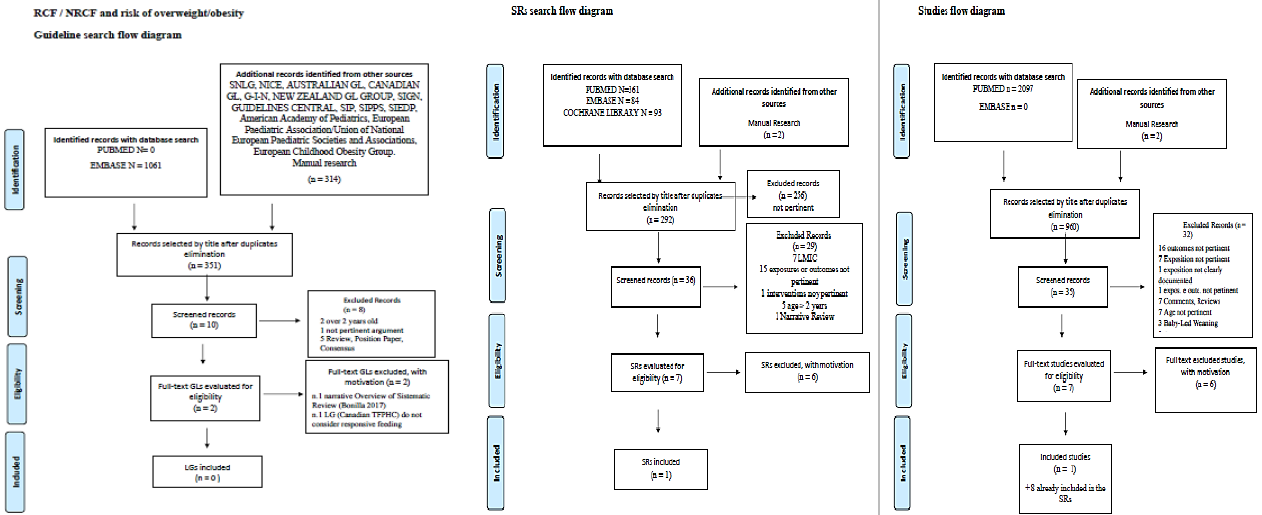
Figure 2. RCF/NRCF and risk of overweight/obesity. Flow diagram of the guidelines, SRs, and studies search.